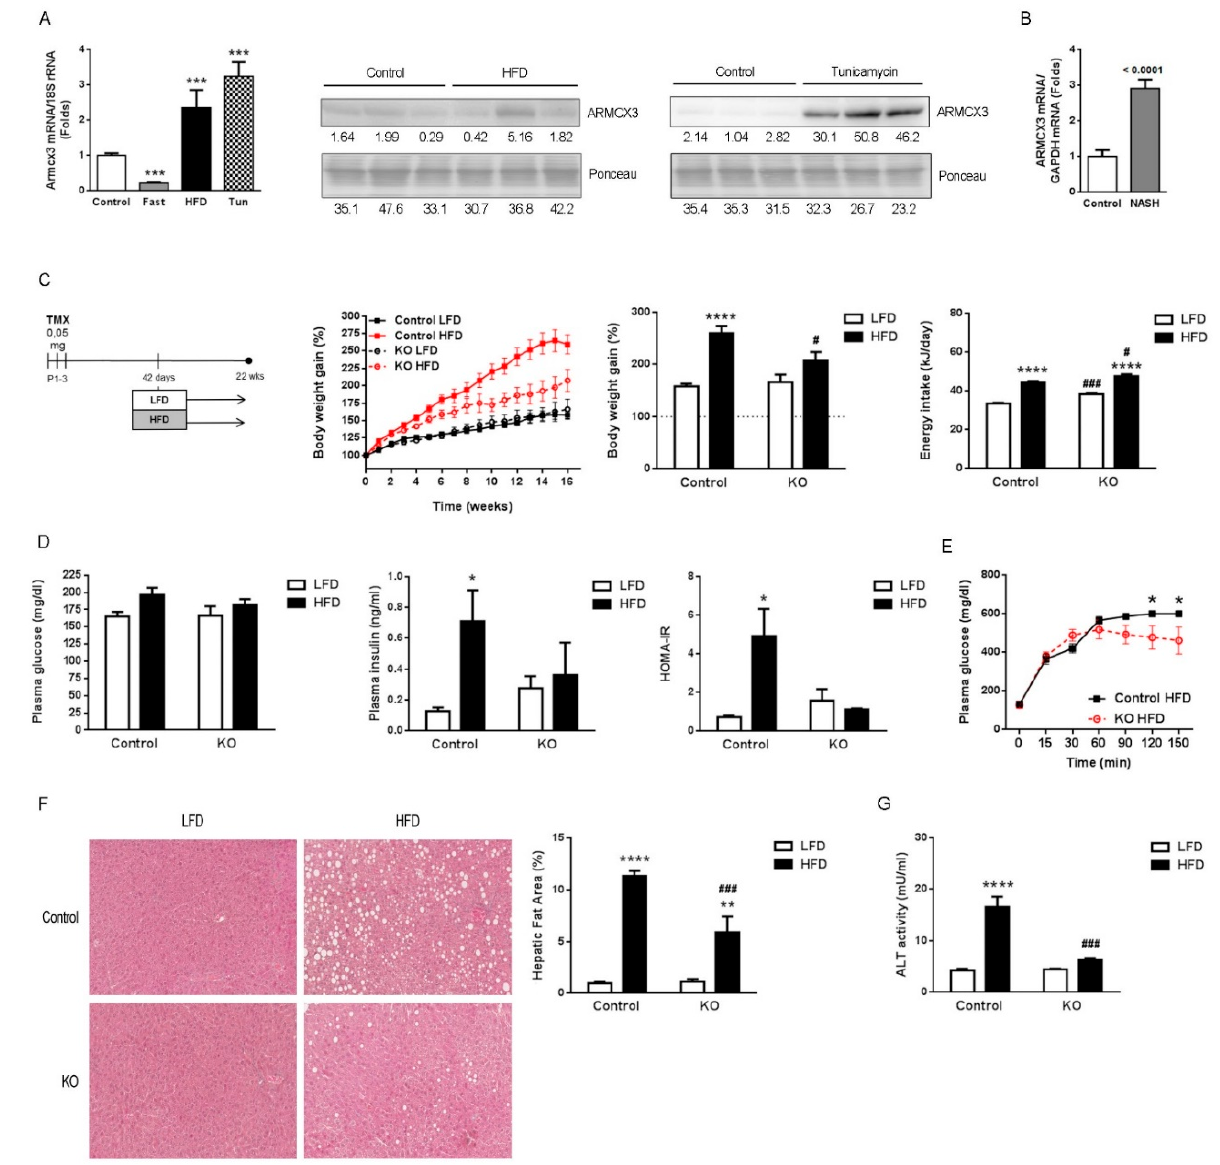
Figure 1. ARMCX3 deletion reduces the susceptibility of mice to high-fat diet (HFD)-induced obesity and metabolic alter- ations. ( A ) Armcx3 mRNA levels in livers of mice exposed to regular feeding conditions (Control), overnight fasting (Fast), high-fat diet (HFD) or 24 h after intraperitoneal injection with 2 mg/kg tunicamycin (Tun) (left). Immunoblot of ARMCX3 protein levels and loading control (Ponceau staining) in livers from mice fed HFD or treated with tunicamycin for 24 h (right) (For uncropped immunoblots here and thereafter, see File S1). ( B ) ARMCX3 mRNA levels in liver from healthy individuals (control, n = 19) and NASH patients ( n = 24). ( C ) Schematic representation of the study design: 6-week-old f Armcx3/Cre- (Control) and ARMCX3-KO mice (tamoxifen-induced Cre activity) (KO) were fed low-fat diet (LFD) or HFD for 16 weeks, (left). Body weight curves (left, central), body weight gain (right, central) and dietary energy intake (right). ( D ) Glycemia (left), insulinemia (middle) and HOMA-IR index (right). ( E ) Glucose tolerance curves. ( F ) Representative microscopic pictures of H&E-stained livers (left), and quantification of the percentage of total area occupied by fat (right). Magnifi- cation: 10 × . ( G ) Serum ALT levels. Bars indicate means ± SEM; n = 6–8 mice per group. T-student, Mann-Whitney or Two-Way ANOVA test with Tukey or Dunnet post hoc corrections were used. * p ≤ 0.05, ** p ≤ 0.01, *** p ≤ 0.001 and **** p ≤ 0.0001 for comparisons between diets or treatments, and # p ≤ 0.05, ### p ≤ 0.001 for comparisons between